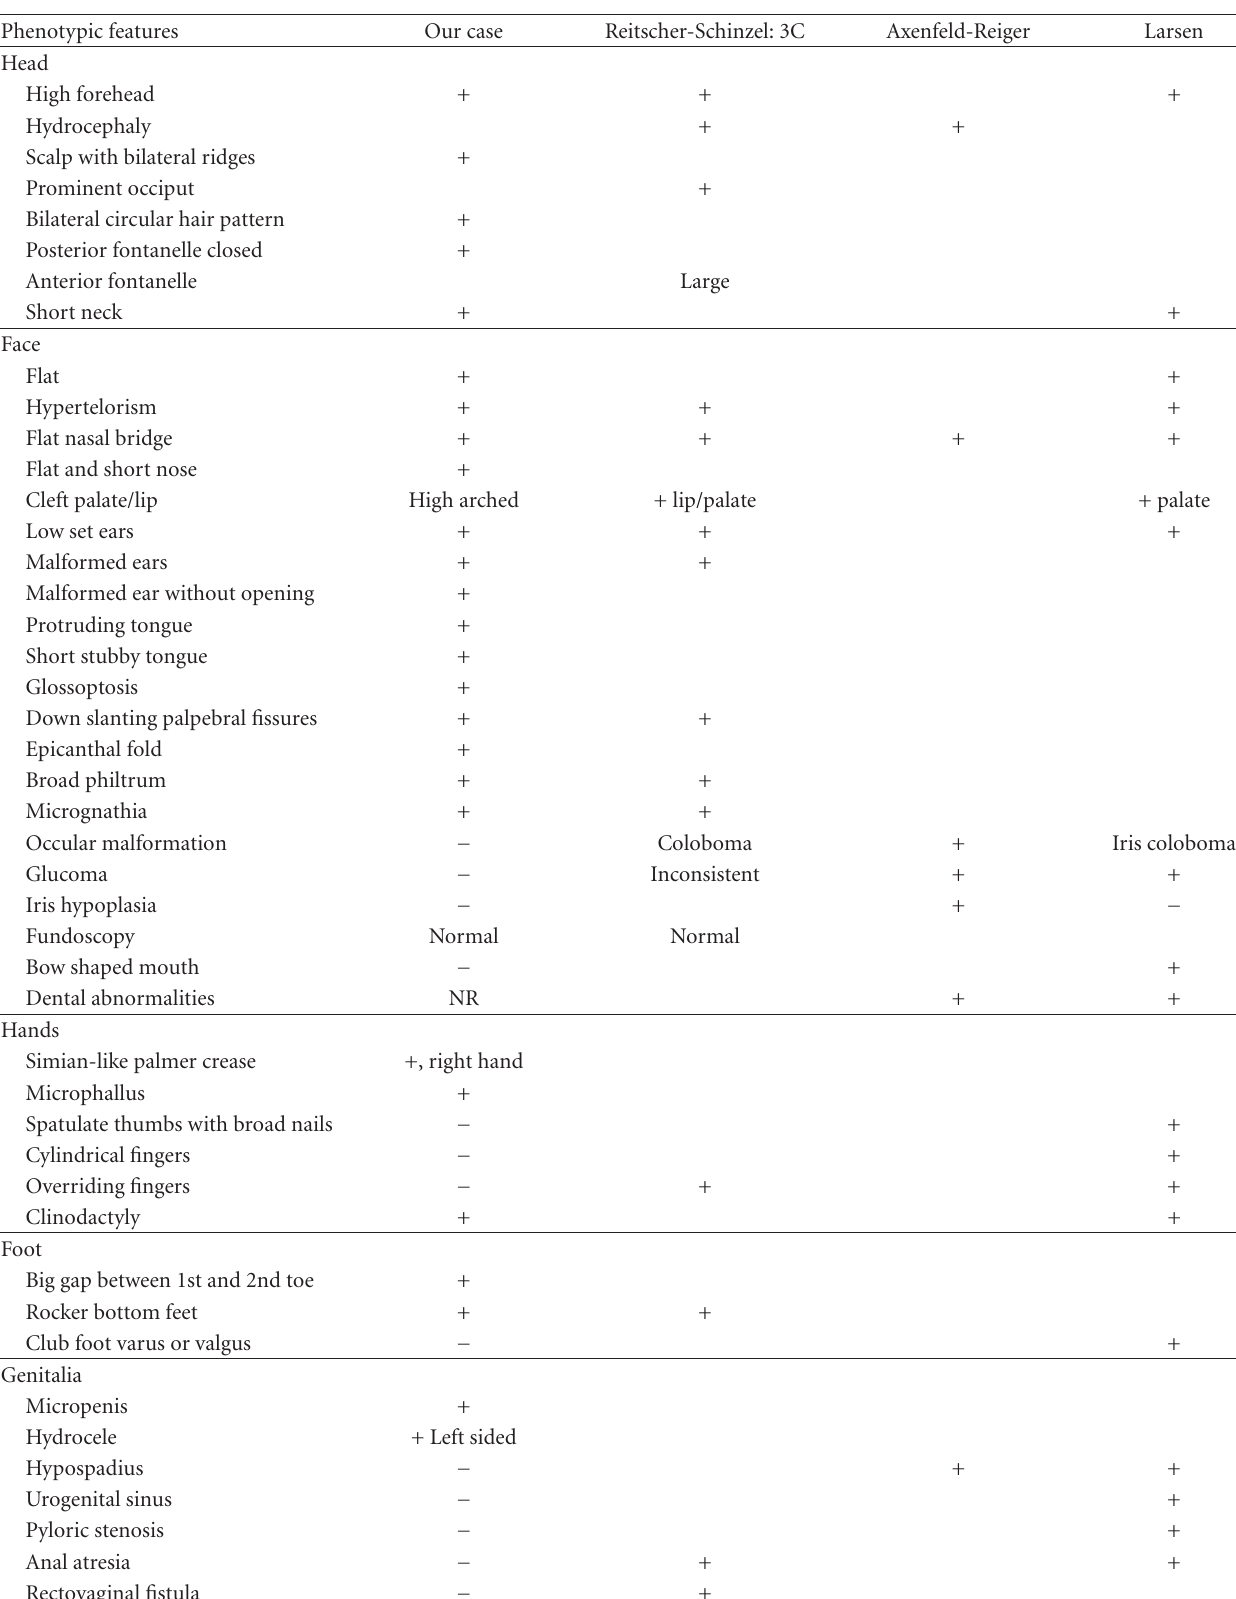
Table 1: Phenotypic features recorded in di ff erent allied syndromes associated with